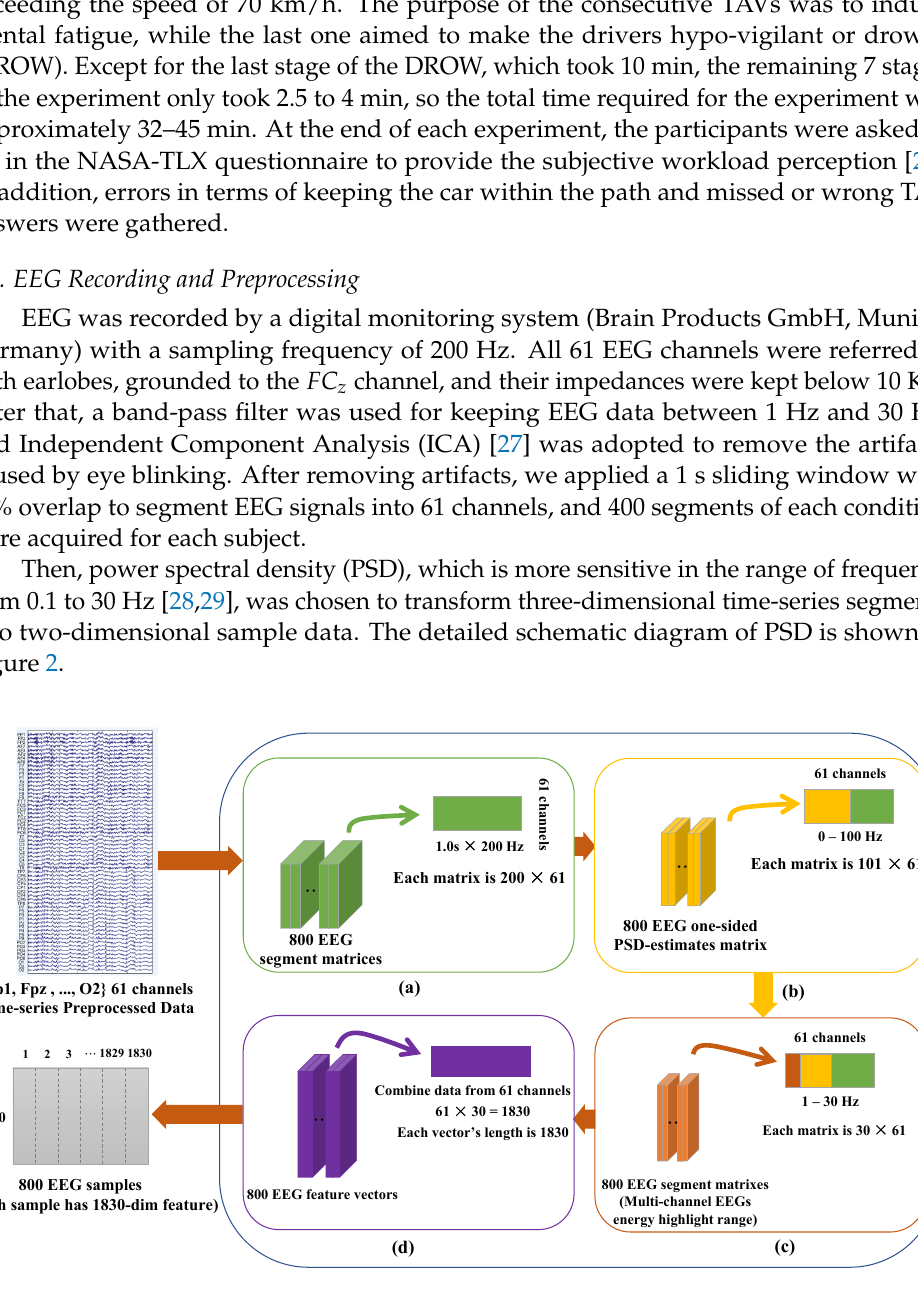
Figure 2. Schematic Diagram of electroencephalogram (EEG) power spectral density (PSD) extraction. (( a ) shows that, we obtained 400 segment matrices for each condition regarding 61 EEG channels, and due to 200 Hz of sampling frequency and 1 s sliding window, the dimension of each matrix was 200 × 61; ( b ) reveals the one-side PSD estimate of the 100 Hz EEG signals, which means the logarithm of the signal power at an integer frequency between 0 and 100 Hz [29]. Regarding PSD- related frequency band, we chose the range from 0.1 to 30 Hz of EEG as the input signals ( c ). Each segment of the integer frequency between 0 and 30 Hz contained 30 EEG powers and 1830 powers for 61 channels. Correspondingly, the 400 × 1830 of dimensional feature vectors in each segment were obtained at the end, as shown in ( d